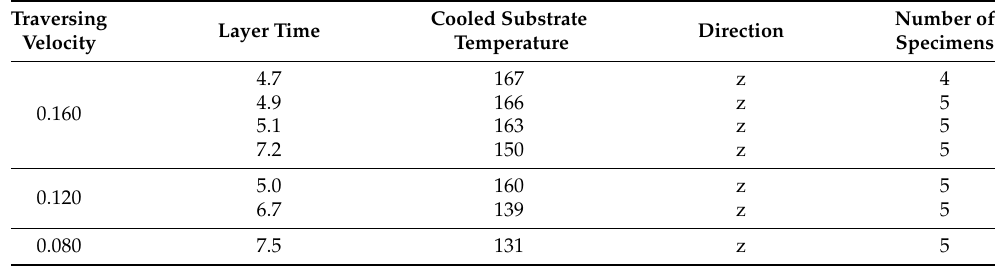
Table A2. Manufactured and tested wide cooling setups for a volumetric throughput of the pressur- ized air of 50% and a cooling distance of 100